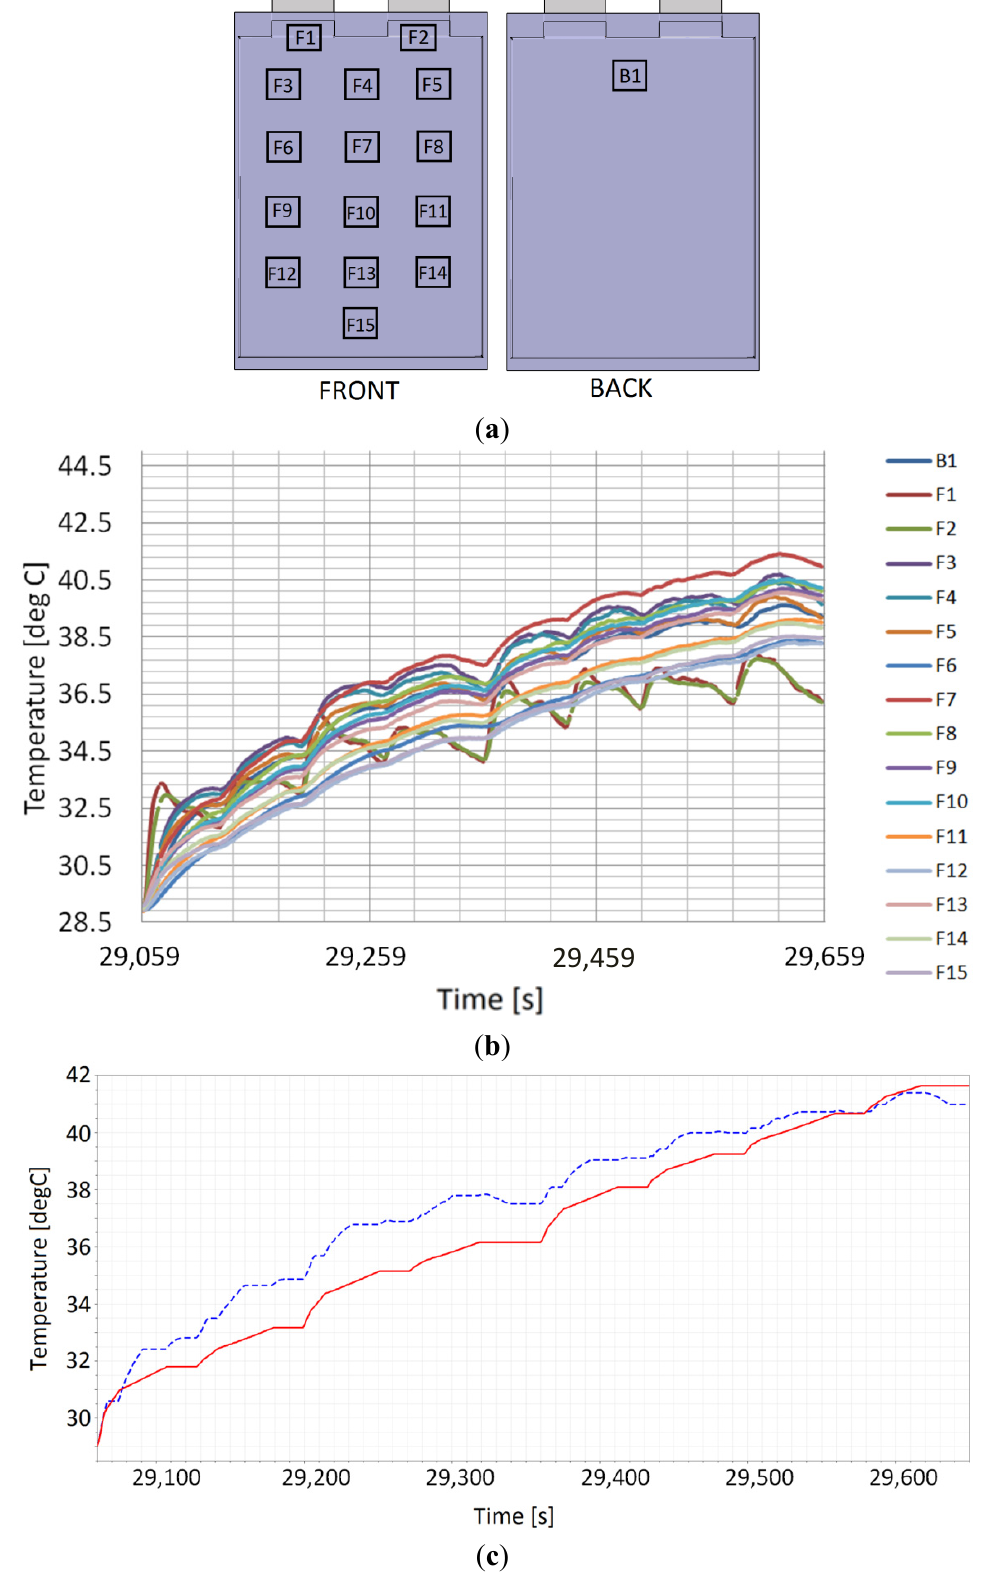
Figure 8. ( a ) Depicting the placement of thermocouples on the LFP 20-A·h pouch cell; ( b ) a plot of temperatures logged by thermocouples placed on an LFP pouch cell as shown in ( a ) under a load cycle depicted in Figure 7a; and ( c ) a comparison of temperature logged by thermocouple F7 and the predicted effective cell